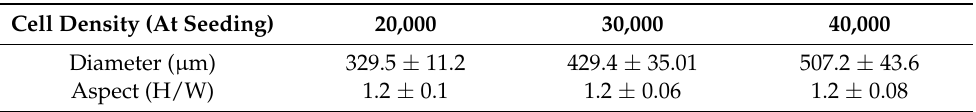
Table 2. Values of diameter and aspect of osteospheres seeded at different cell densities, on the 4th day of formation. Cell Density (At